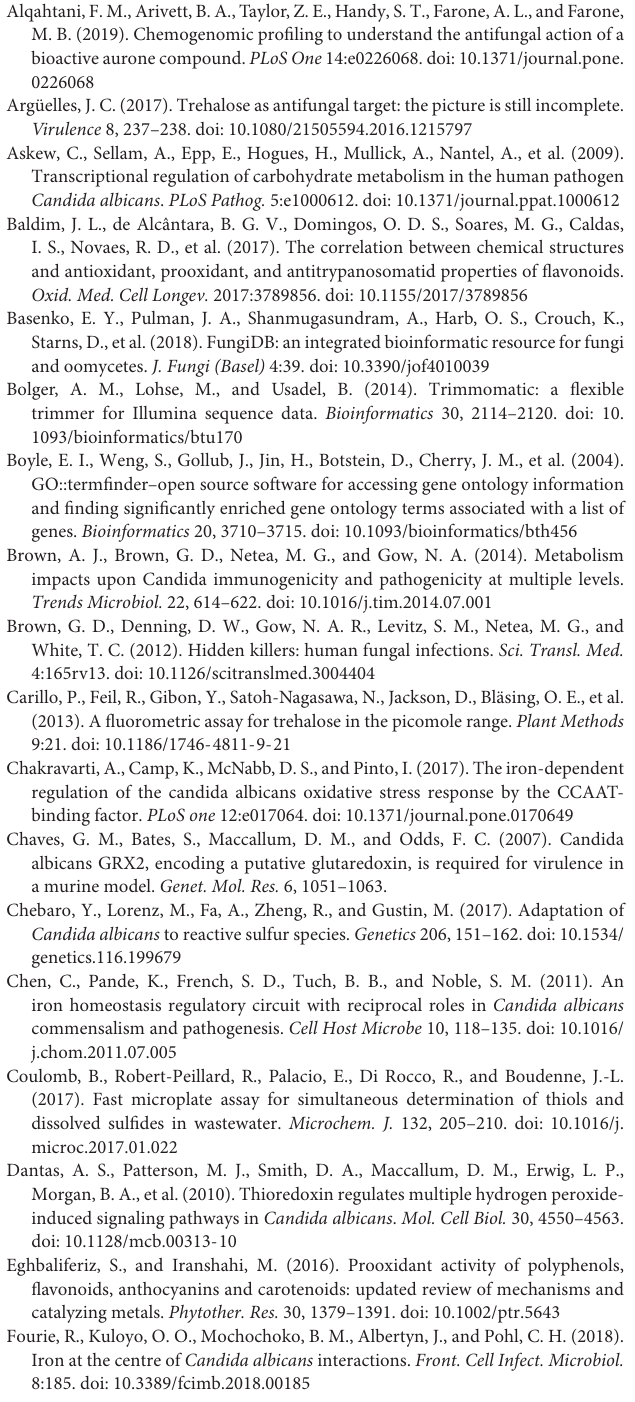
Supplementary Figure 4 | Growth curves of SH1009 + FeCl 3 treatments. Supplementary Table 1 | Selectivity index of SH9051. Supplementary Table 2 | Gene expression analysis of SH1009.